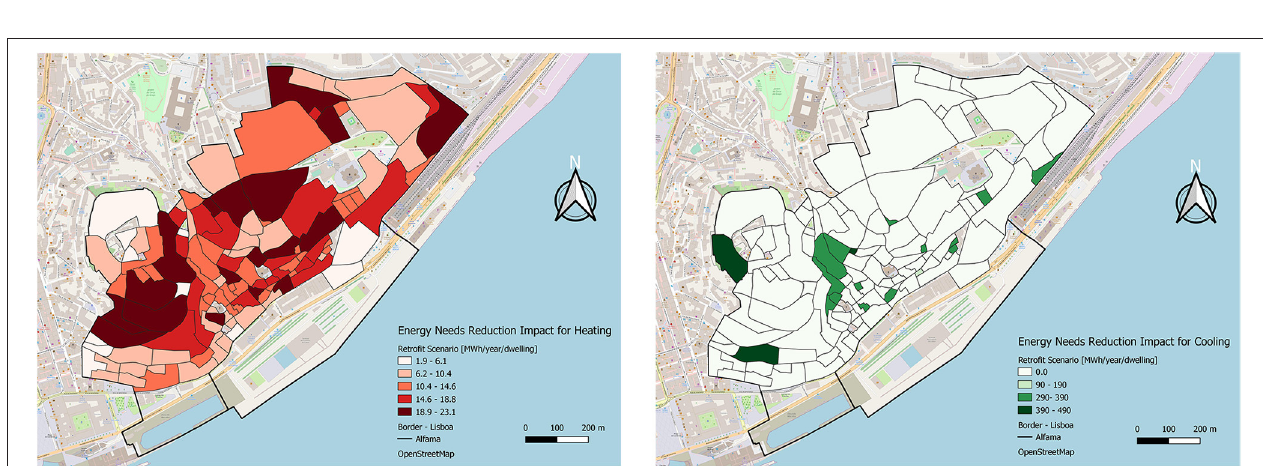
FIGURE 4 | Space heating (left) and cooling (right) energy needs per average dwelling in Alfama subsections after retrofitting measures.